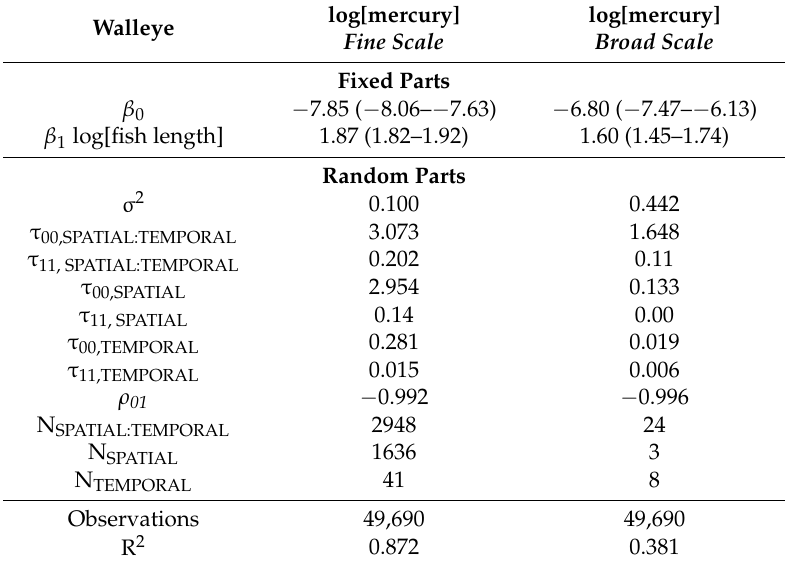
Table 3. Summary of the best-fitting LMEM for Walleye at fine and broad scale of analysis, where mercury concentration is predicted as a function of fish length with spatial, temporal and spatio-temporal interactions as random effects. (Note: numbers in parenthesis show 95% confidence interval; subscripts ‘spatial’ and ‘temporal’ in the random parts are different for the fine and broad scale of analysis: spatial (fine-scale)—waterbodies; temporal (fine-scale)—year; spatial (broad-scale)—5 ◦ latitudinal zones; temporal (broad-scale)—5-year time period).